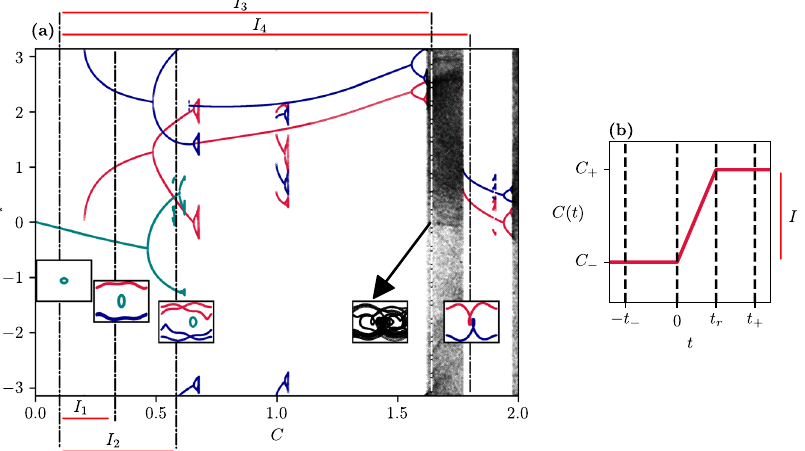
Figure 1. ( a ) Bifurcation diagram of a typical nonlinear system with frozen-in control parameter C : the x -coordinates of the long-term attractors are shown on a stroboscopic map. ( b ) Schematic diagram of the parameter drift scenario used in the paper. The scenario covers a control parameter interval I = [ C − , C + ] corresponding to a control parameter change Δ C = C + − C − . The limiting C values of the scenarios are marked by vertical dashed-dotted lines in ( a ). The continuous-time attractors belonging to these values are given in the insets. The control parameter intervals I n , n = 1, … , 4 investigated in the main text are marked by line segments along the frame of the bifurcation